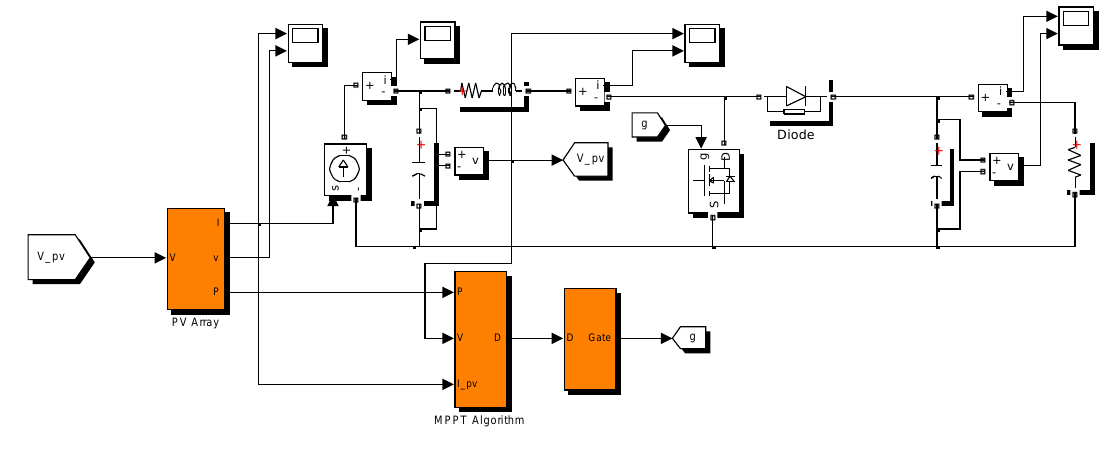
Figure 11. Configuration of system.